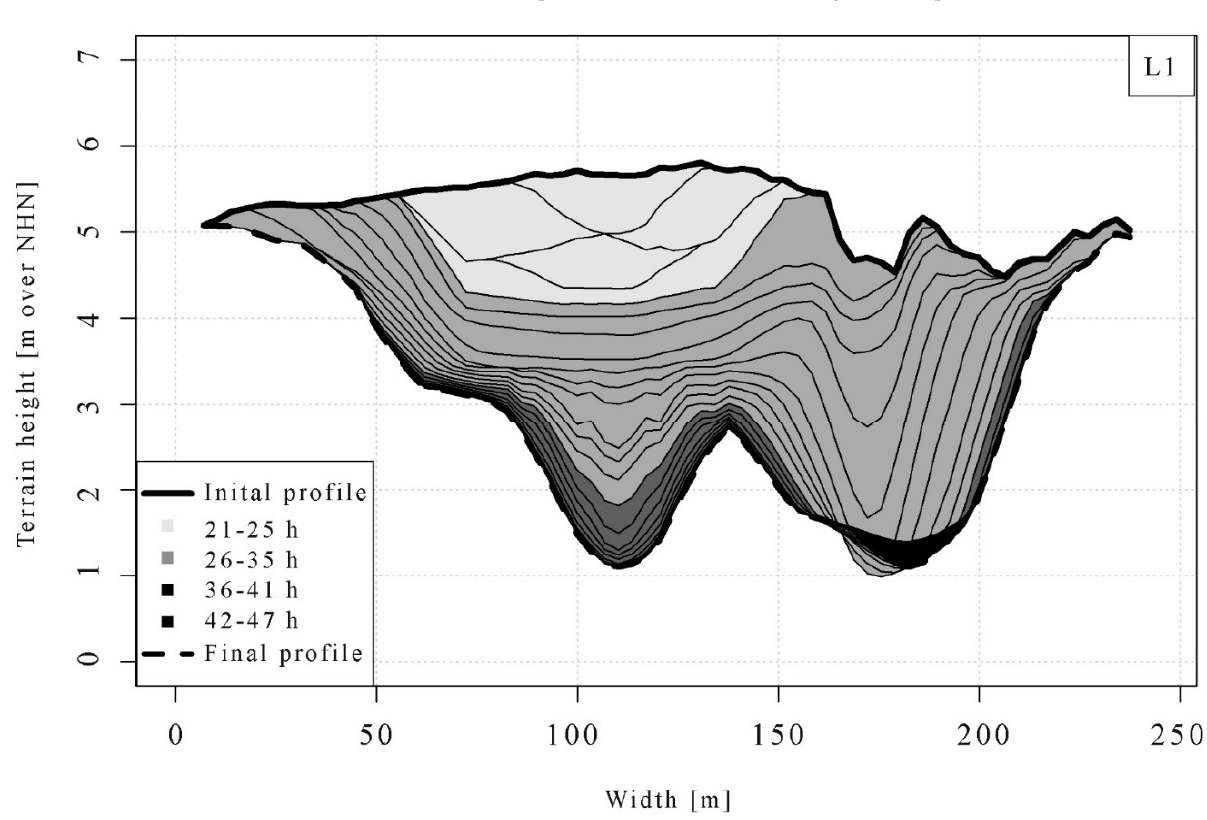
Figure 18. Development of breach B2 and B3 during the design flood, profile L1 [35].